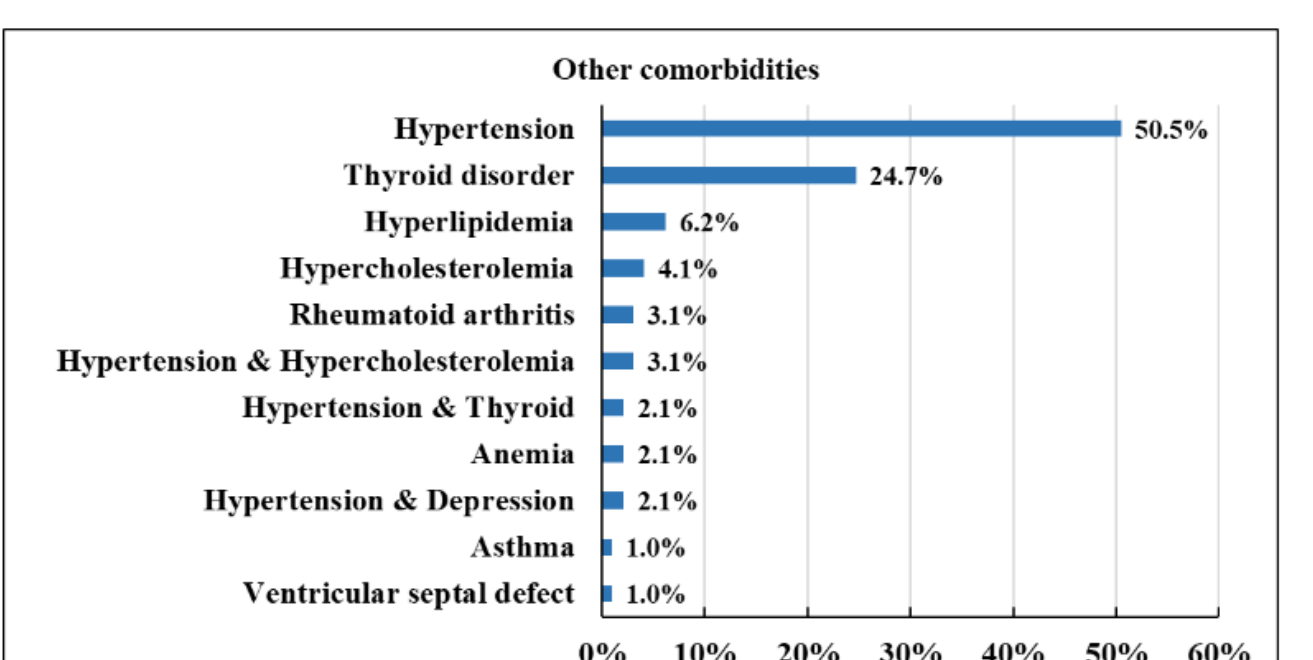
Figure 1. Frequency distribution of comorbidities with type 2 DM ( p value = 0.002).